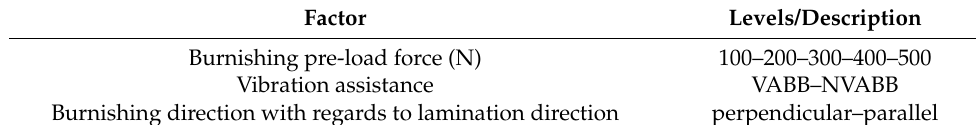
Table 2. Summary of the main testing parameters varied during the first experimental phase.